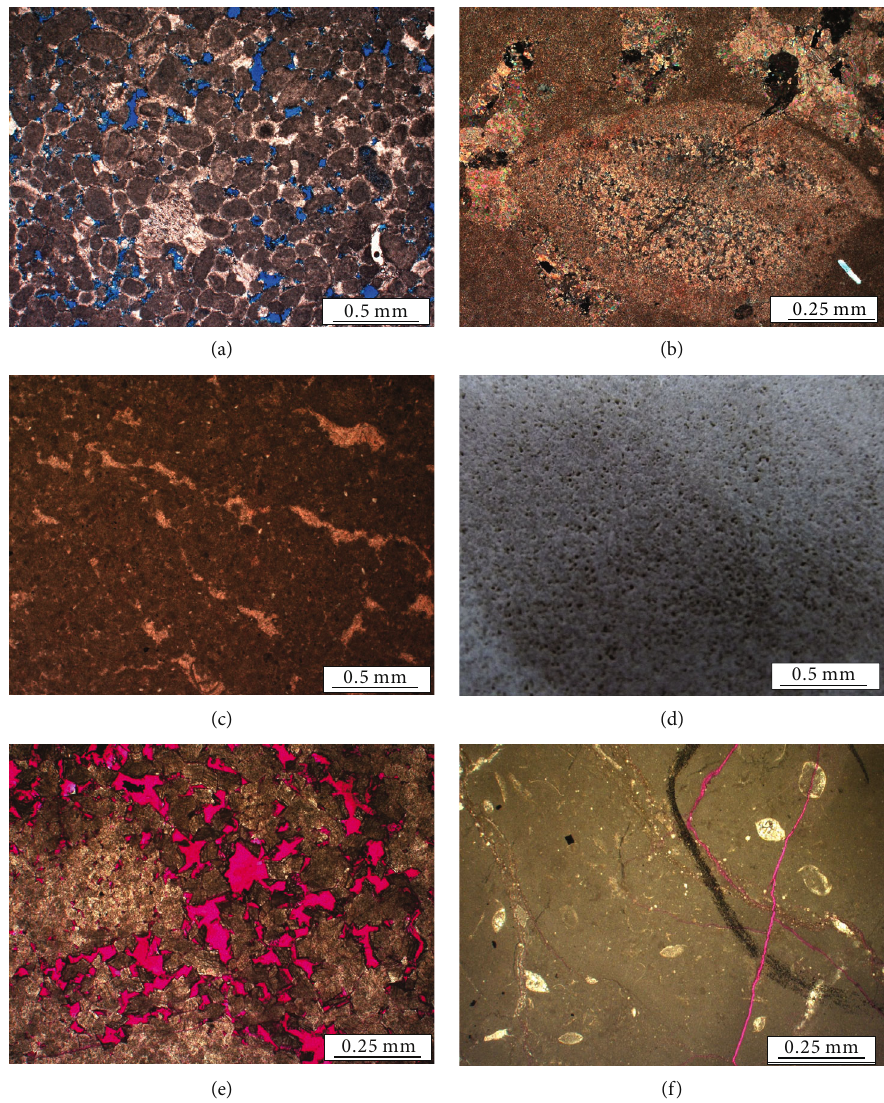
Figure 4: Reservoir space of Yingshan Formation. (a) X203 well, 6581.72 m. (b) X7 well, 5800 m. (c) X7 well, 5965.5m. (d) X203 well, 6567.38m ~ 6573.38m. (e) X9 well, 6265.01m. (f) X41 well,